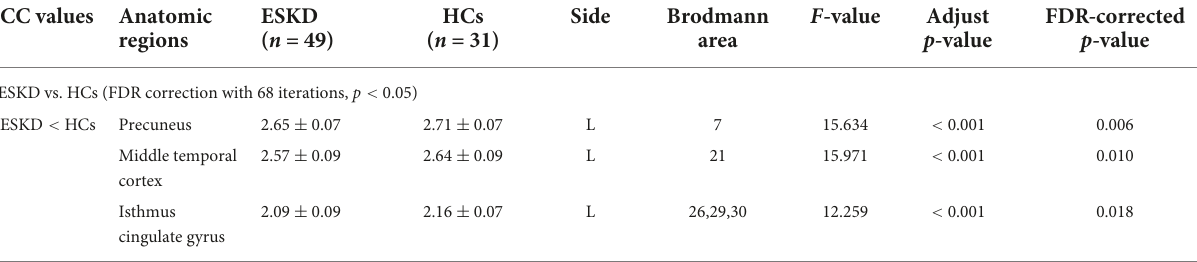
TABLE 3 Brain regions with significant differences in CC values between patients with ESKD and HCs. F -value Adjust CC values Anatomic ESKD HCs Side Brodmann FDR-corrected p -value p -value regions ( n = 49) ( n = 31) area ESKD vs. HCs (FDR correction with 68 iterations, p < 0.05) ESKD < HCs Precuneus 2.65 ± 0.07